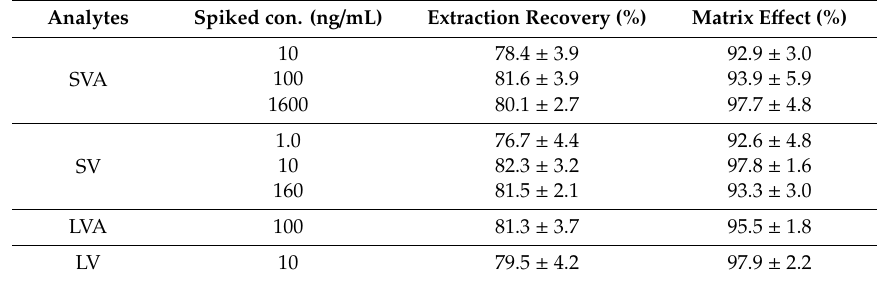
Table 3. Extraction recoveries and matrix e ff ects of SVA, SV and IS (LVA and LV) in rat plasma (mean ± S.D, n = 5).